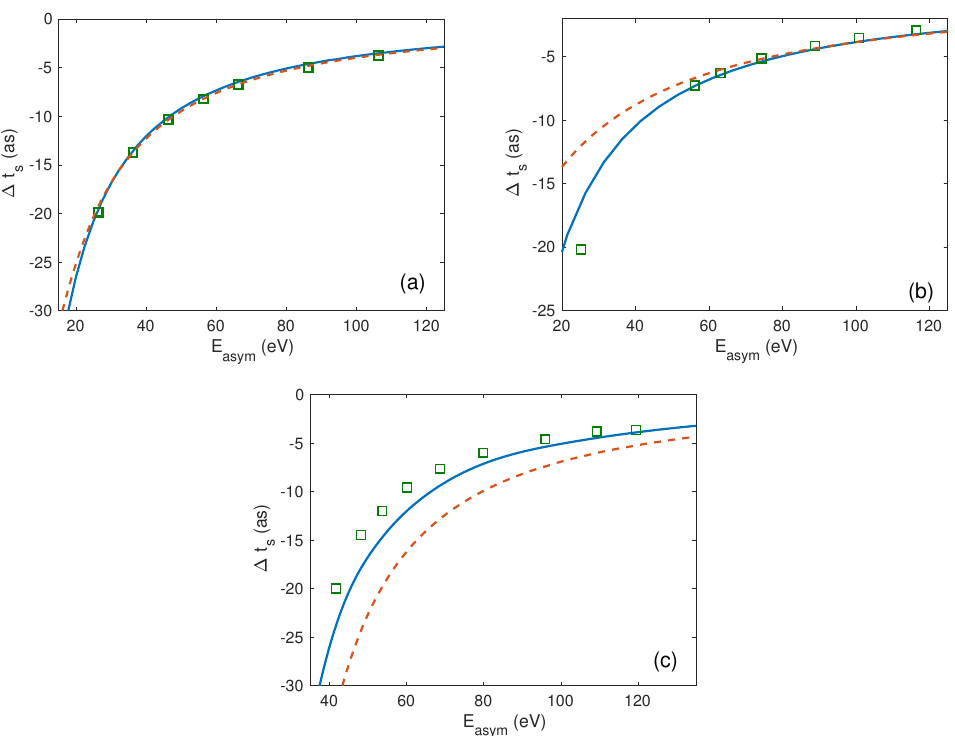
Figure 2. Streaking time delays for hydrogen atom ( a ); helium atom ( b ); and neon atom ( c ): a comparison of results of ab initio calculations is shown (open squares, taken from [24] for hydrogen and helium, [25] for neon), classical calculations (solid lines, Equation (8)) and predictions of analytical model formula (dashed lines, Equation (11)). For neon atoms, only the d-channel is considered in the analytical